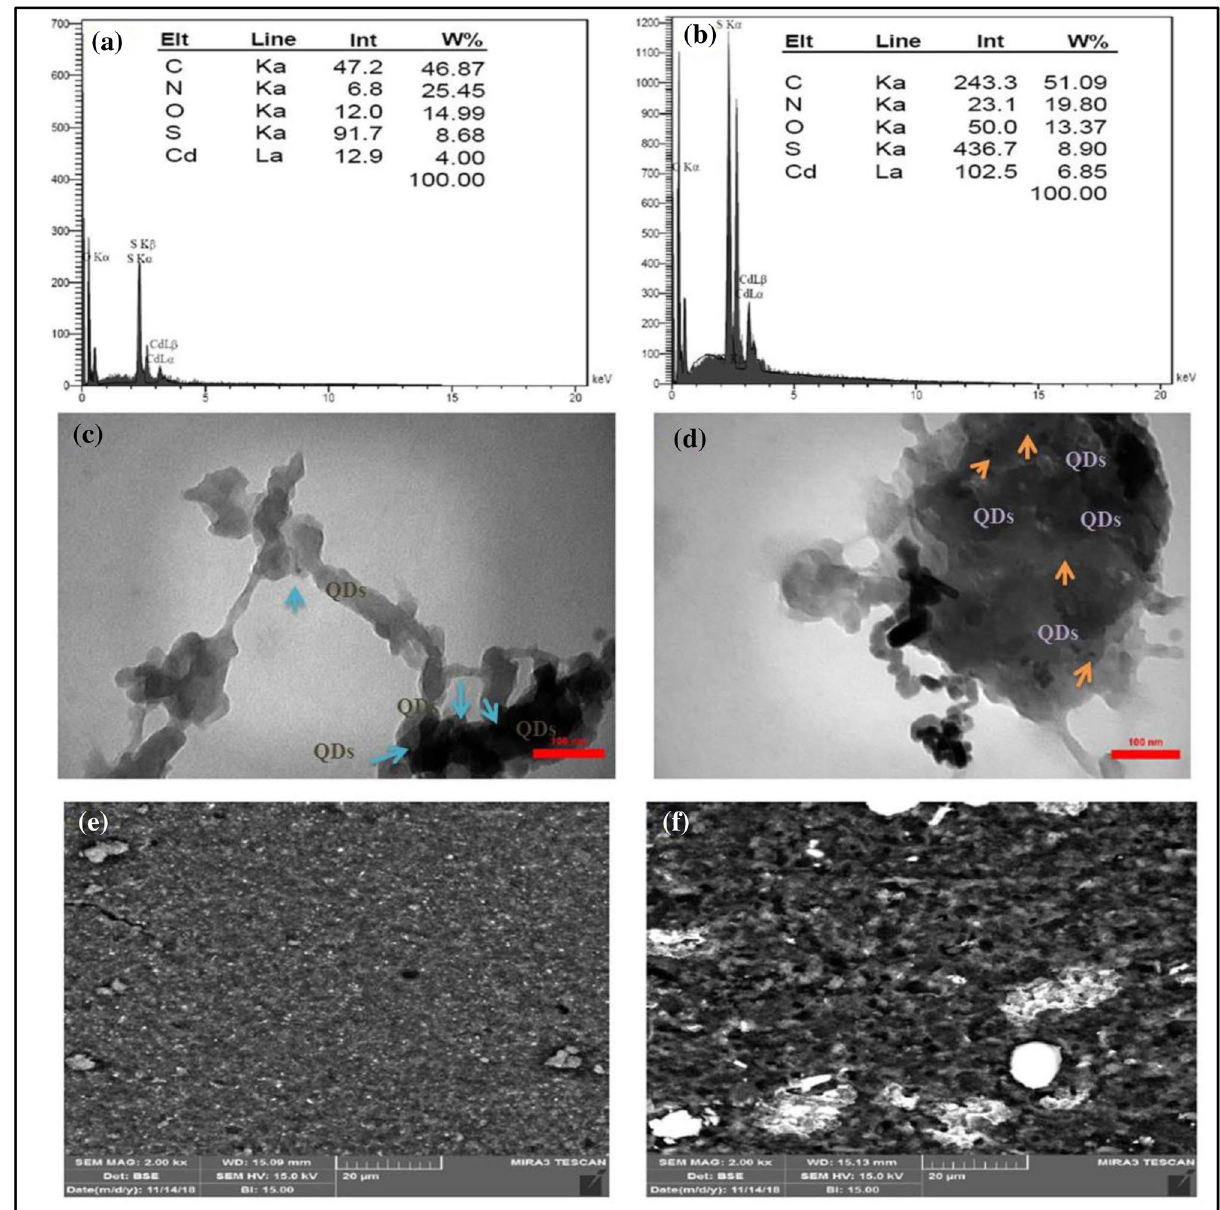
Figure 7. The images of EDX spectra of CdS@HPEc-g-PANi ( a ), mCdS@HPEc-g-PANi ( b ), TEM images of CdS@HPEc-g-PANi (c), mCdS@HPEc-g-PANi ( d ) and EDX-map of CdS@HPEc-g-PANIi ( e ) and mCdS@ HPEc-g-PANi ( f